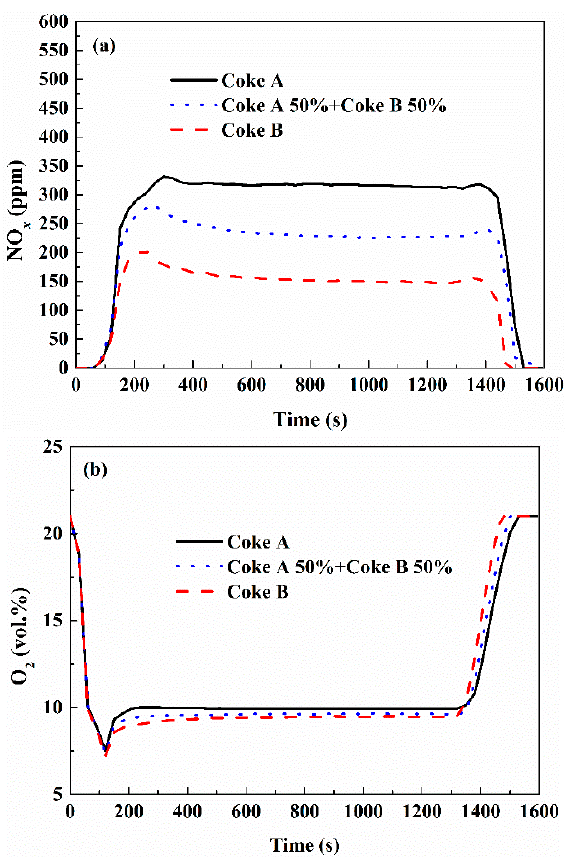
Figure 6. NO x emissions ( a ) and O 2 content in flue gas ( b ) with different fuel types.